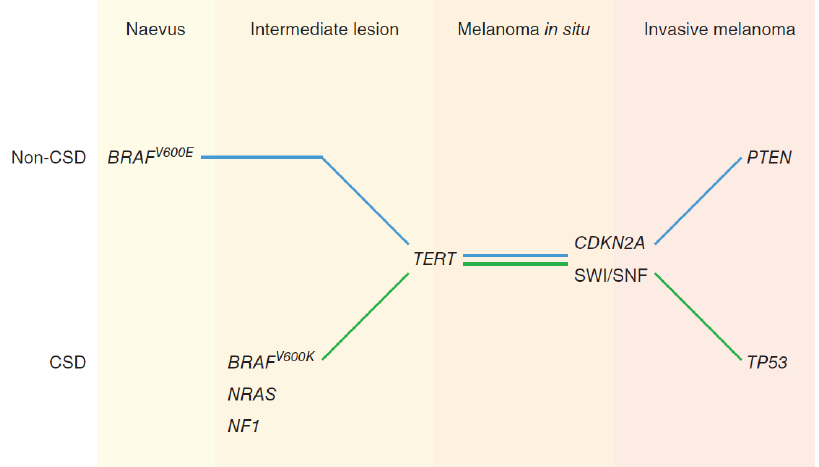
Figure 5. Melanoma Progression on Chronic Sun Damaged (CSD) versus Non-CSD Skin: (Reproduced from “Melanoma” by Guterres et al. with permission from the publisher John Wiley and Sons, Wiley Online Library: Copyright © 2020 John Wiley & Sons. Ltd. (Hoboken, NJ, USA) [31] ). Melanoma progression can be separated into the two pathways of Non-CSD (non-chronically sun damaged) skin and CSD (chronically sun damaged) skin melanomas. Non-CSD melanomas often have a mutation in BRAFV600E with a resultant benign nevus. In contrast, CSD skin forms intermediate dysplastic lesions after mutations occur in Non-BRAFV600E (BRAFV600K), NF1 , and NRAS . Resultant TERT reactivation leads to progression to early melanoma for both Non-CSD and CSD skin. If the lesions acquire further loss of function mutations in CDKN2A or SWI/SNF , the lesion is keyed up for invasion. Lastly , PTEN (more common in BRAFV600E melanomas) inactivation or TP53 ( NRAS and NF1 melanomas) inactivation leads to more invasive melanomas [31] .